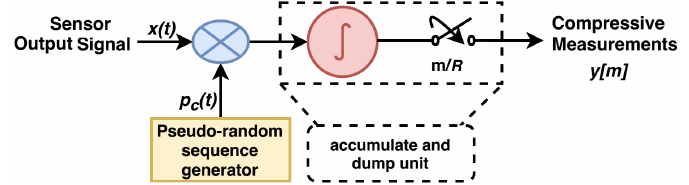
Figure 5. Stage-I: compressive acquisition of sensor output signal using random